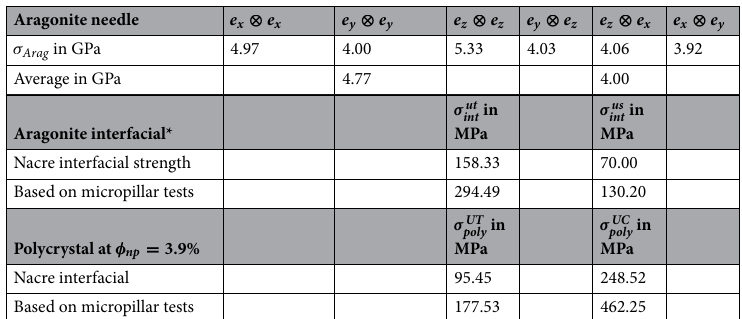
Table 2. Aragonite and polycrystal yield strength: Yield strengths for the aragonite needle and the polycrystalline coral skeleton not exposed to acidified waters. e i with i = the molecular dynamics test. σ ut int and σ us int denote interfacial tensile and shear strength of the aragonite crystal while σ UT poly and σ UC poly are the tensile and compressive strengths of the polycrystalline skeleton not exposed to acidified waters, respectively. *Barthelat et al. 52 argued that dry nacre approximates the brittle, interfacial yield strength of pure aragonite. We assume that a nacre platelet loaded along the in-plane axis resembles a similar loading situation as the aragonite needles in the CWC skeleton. Consequently, we use tensile 52–54 and shear 52 strengths for nacre as a lower bound, with a review of tests given by Sun and Bhushan 55